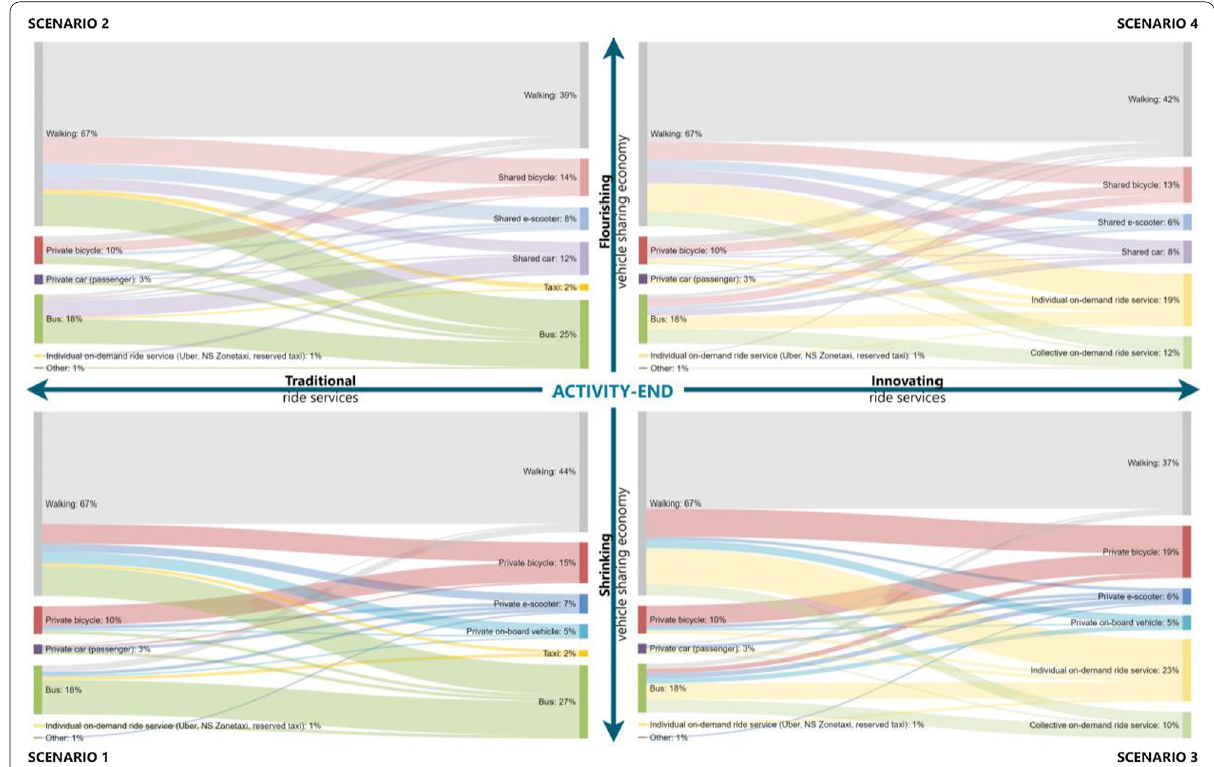
Fig. 6 Expected modal shift for activity‑end trips in all four